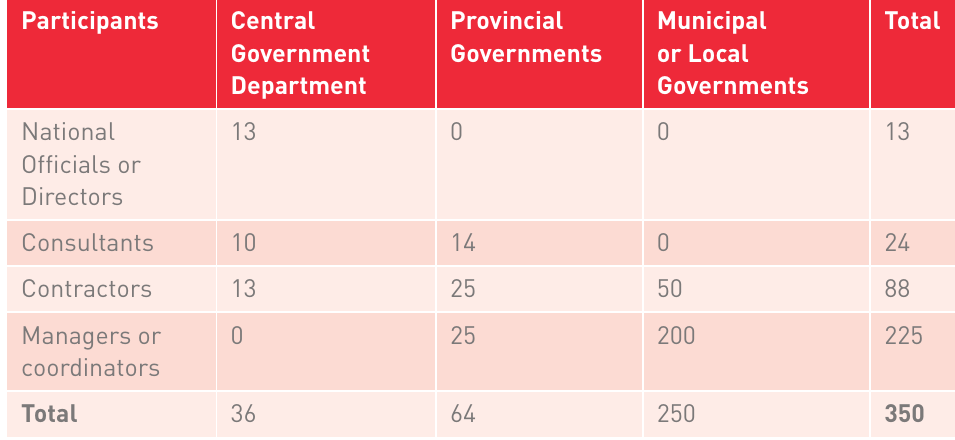
Public Sector Groups and Number of projects involved in Post-disaster Reconstruction Projects purposively selected for semi-structured Interviews and